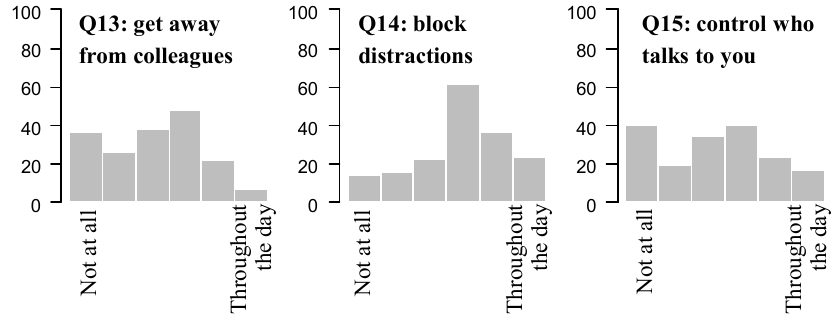
Figure 2. How participants across all offices felt about their personal work area. There is high correlation between crowdedness, feeling that people are too close and satisfaction.